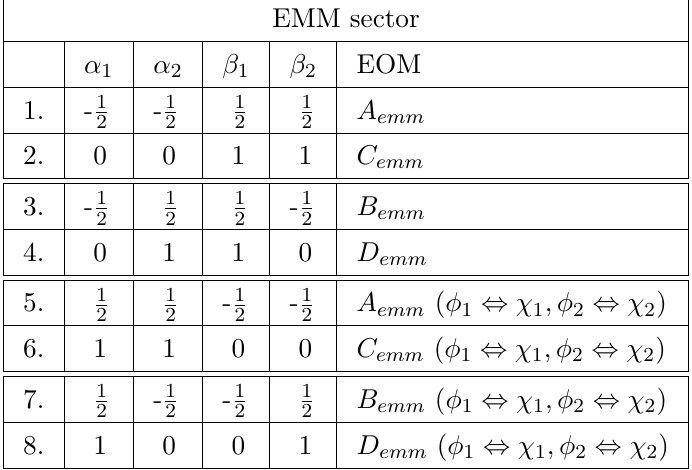
Table 3. Scaling of spinors in EMM sector: [1,2] satisfy (cid:12) 1 ; 2 (cid:0) (cid:11) 1 ; 2 = 1; [3,4] satisfy (cid:12) 1 (cid:0) (cid:11) 1 = 1 and (cid:11) 2 (cid:0) (cid:12) 2 = 1; [5,6] satisfy (cid:11) 1 ; 2 (cid:0) (cid:12) 1 ; 2 = 1; [7,8] satisfy (cid:11) 1 (cid:0) (cid:12) 1 = 1 and (cid:12) 2 (cid:0) (cid:11) 2 = 1 along with